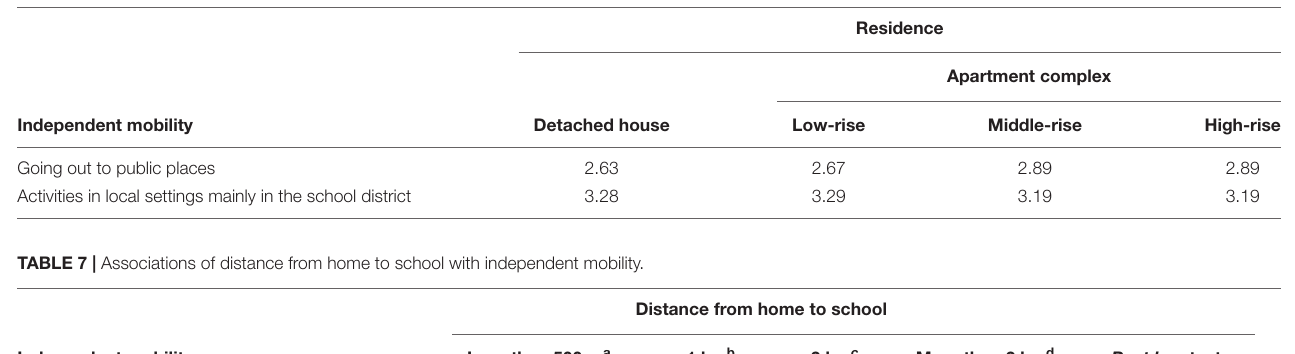
TABLE 6 | Associations of residence with independent mobility.